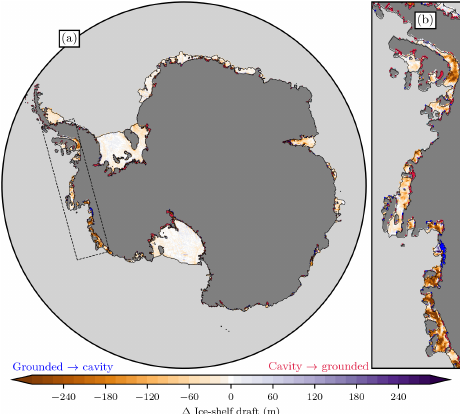
Figure A8. Differences between PARASO initial draft geometry taken from the f.ETISh initialization run (see Sect. 4.3) and BedMachine (Morlighem et al., 2020) (PARASO–BedMachine) for (a) the full Antarctic and (b) a western Antarctica zoom-in. Blue nodes indicate grounded columns in the BedMachine dataset that become cavities in the PARASO initial geometry. Red nodes indicate the opposite (cavity columns turning into grounded ones).